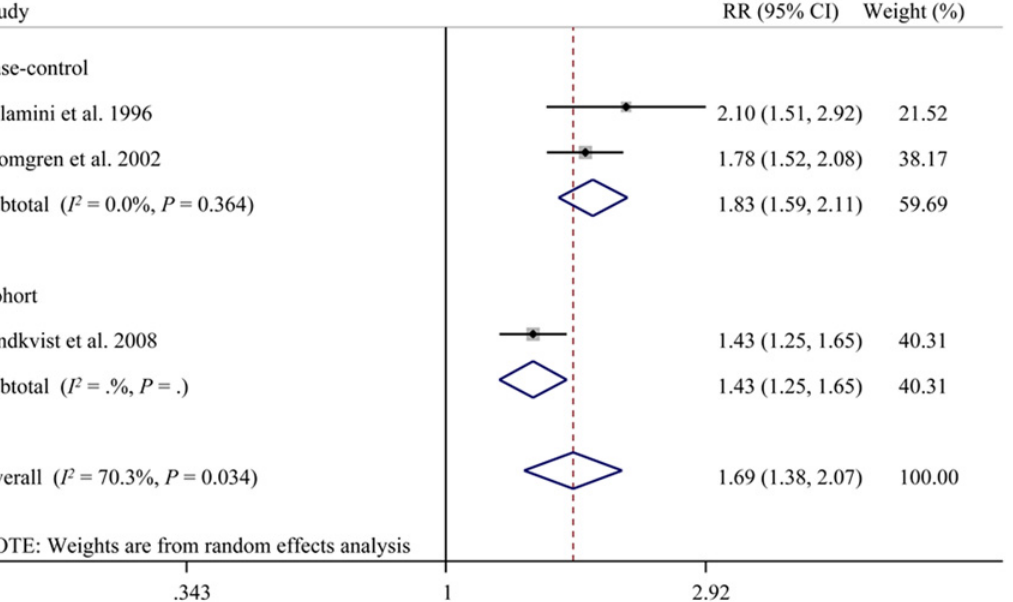
Fig 5. Dose-response meta-analysis of cigarette smoking and the risk of acute pancreatitis. CI, confidence interval; RR, relative risk; RR indicates the risk of acute pancreatitis per 10 cigarettes increment in amount of smoking.